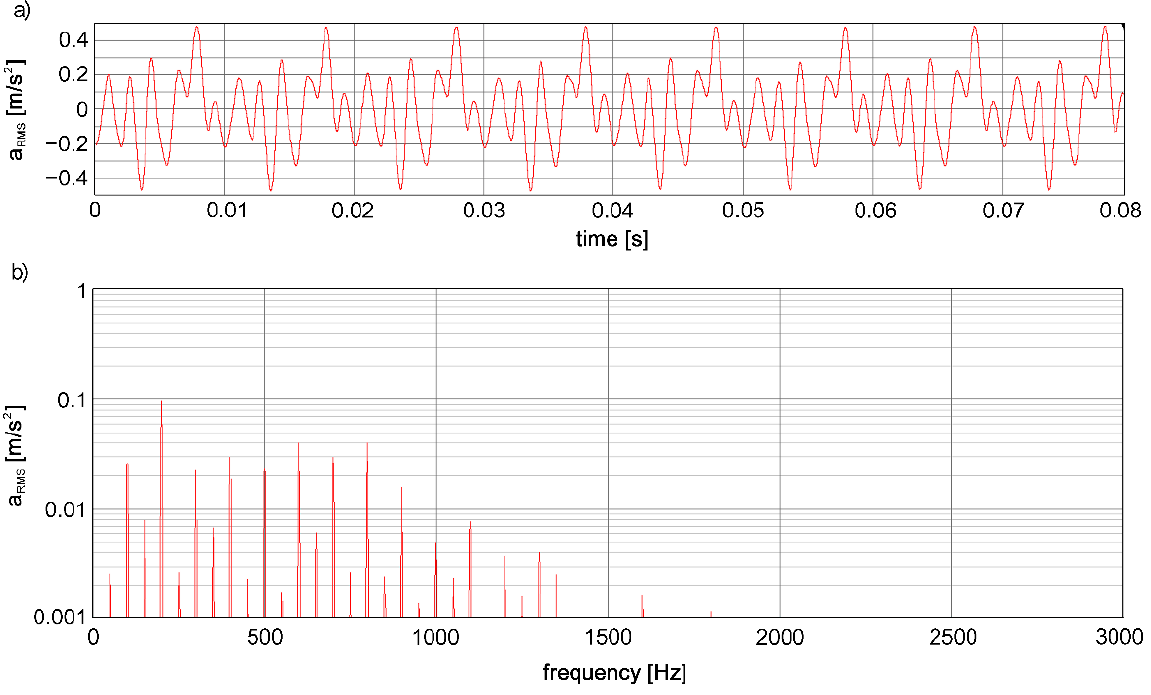
Figure 1. ( a ) Typical time waveform of vibration acceleration recorded on the tank of the power transformer; ( b ) Vibration spectrum calculated using Fourier transform. The measuring system consisted of a vibroacoustic sensor and the data acquisition system, which was connected to a computer with installed DEWESoft X3 software (or its newer version—DEWESoft X). For the measurements was used the Hansford Sensors piezoelectric accelerometer model 1735005406. This sensor is a compact industrial accelerometer with an M12 connector,